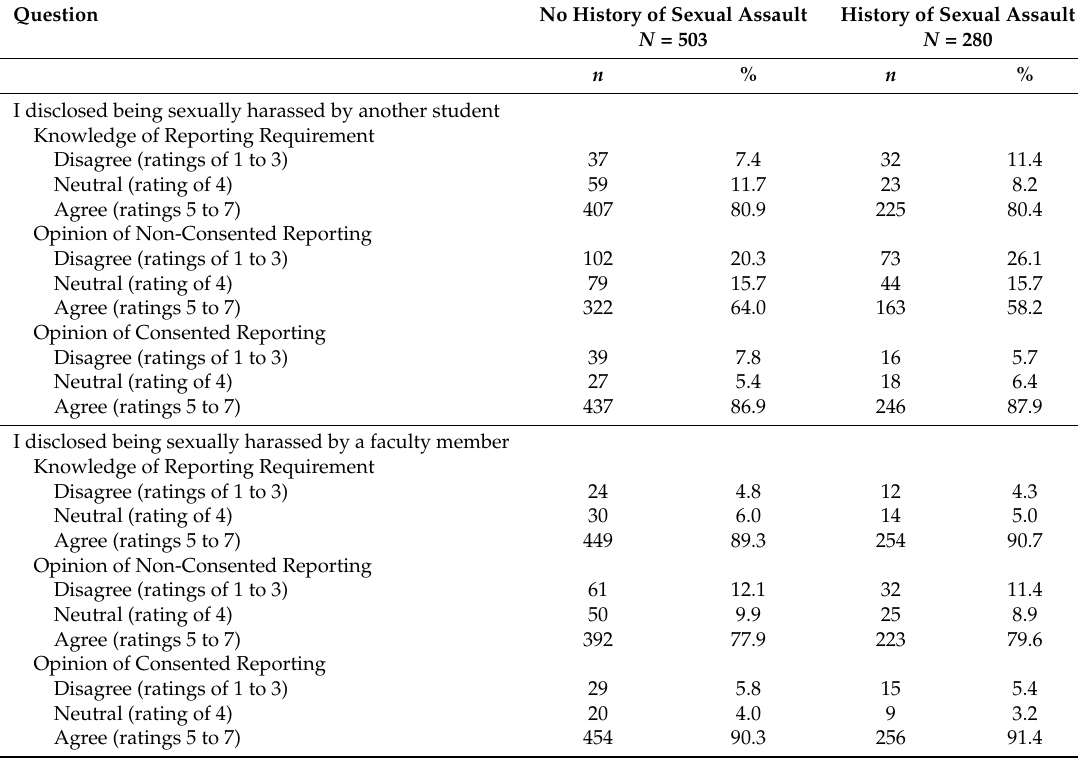
Table 3. Student responses by sexual assault history ( N =